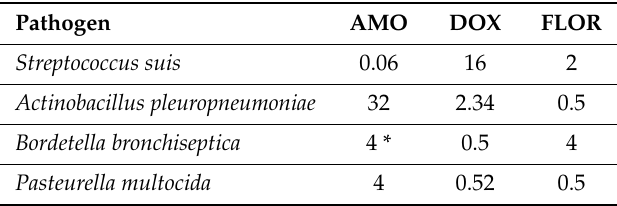
Table 4. MIC 90 (minimum inhibitory concentration at 90%) values (mg / L) of major swine pathogens for amoxicillin (AMO), doxycycline (DOX), and florfenicol (FLOR), based on